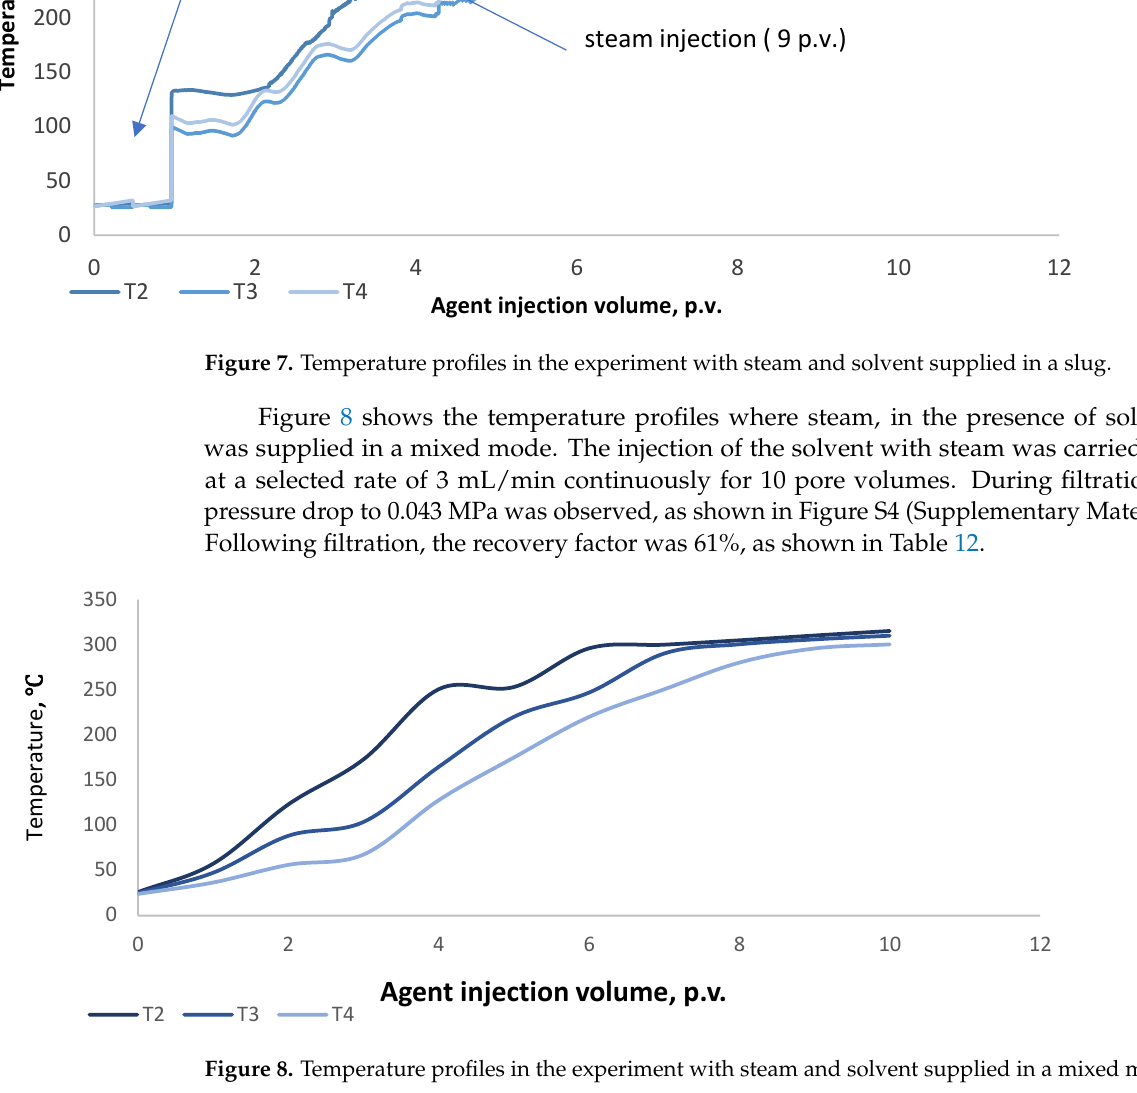
Table 12. Material balance before and after exposure in all experiments.